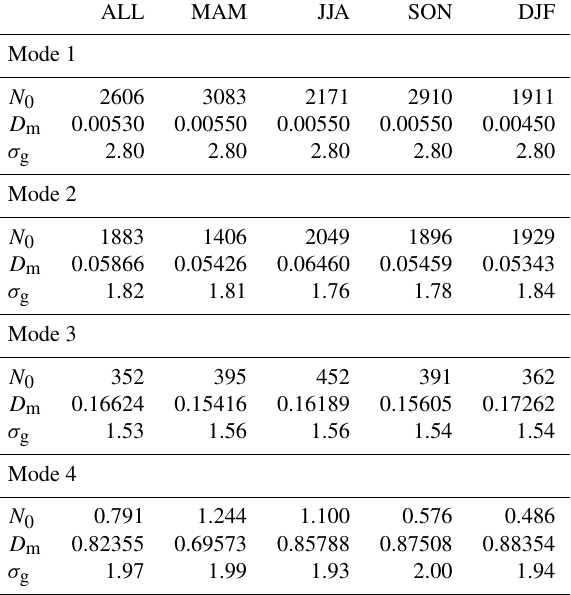
Table 1. Parameters for each mode of the fitted lognormal distribu- tions for the number size distributions shown in Fig. 3. N 0 repre- sents the amplitude of the lognormal distribution and the total num- ber concentration within the mode (cm − 3 ), D m represents the me- dian diameter (µm), and σ g represents the geometric standard devi- ation, all as denoted in Eq. (1) in the text. ALL MAM